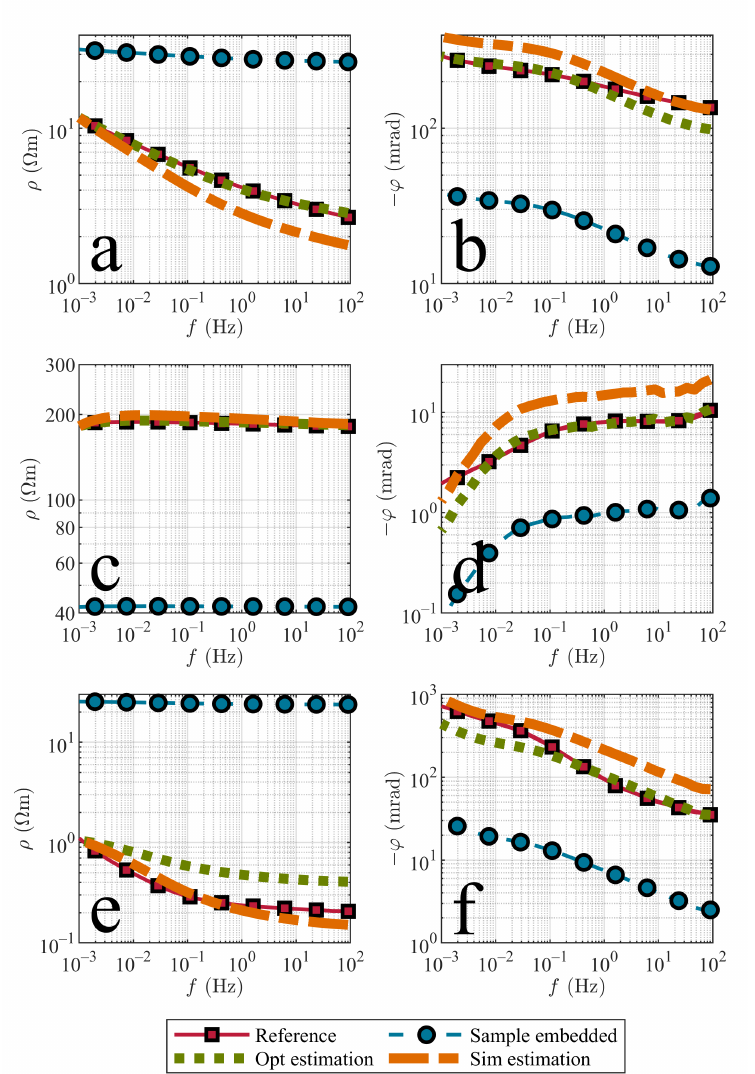
Figure 7. Resistivity magnitude ( left column ) and phase shift ( right column ) spectra of three selected samples. Top row ( a , b ) Fe-rich sample no. 33. Middle Row ( c , d ): Si-rich sample no. 13. Bottom row ( e , f ): Fe-rich sample no. 31. The red squares denote the reference measurements on the cylindrical samples, the blue squares denote the measurements on the embedded samples, the green dotted line is the optimized estimation using Equation (13), and the orange line denotes the result using the dilution factor determined from numerical